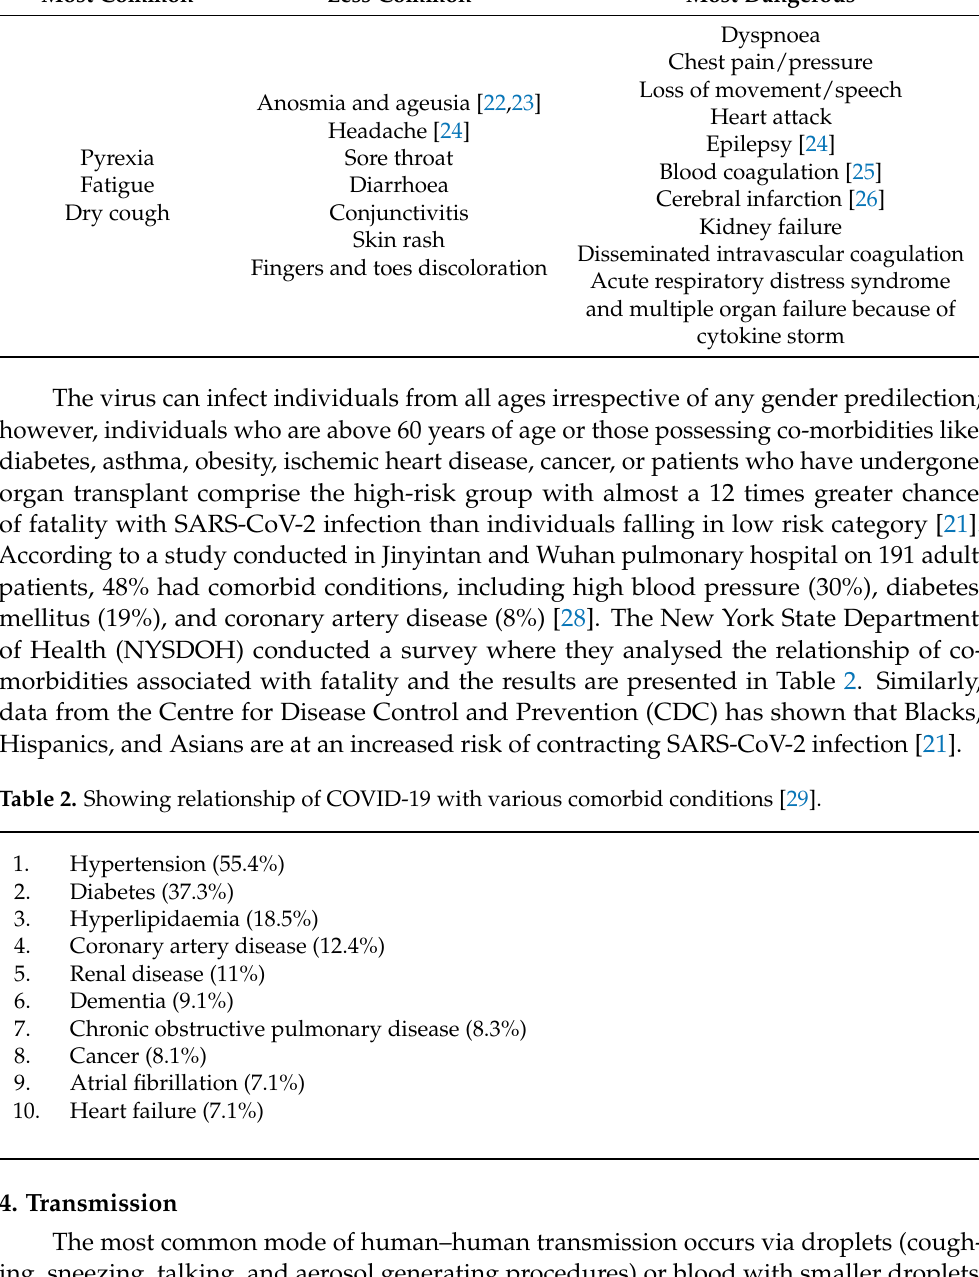
Table 1. Signs and symptoms of COVID-19. Most Common Less Common Most Dangerous Anosmia and ageusia [22,23] Headache [24] Sore throat Pyrexia Diarrhoea Fatigue Conjunctivitis Dry cough Skin rash Fingers and toes discoloration